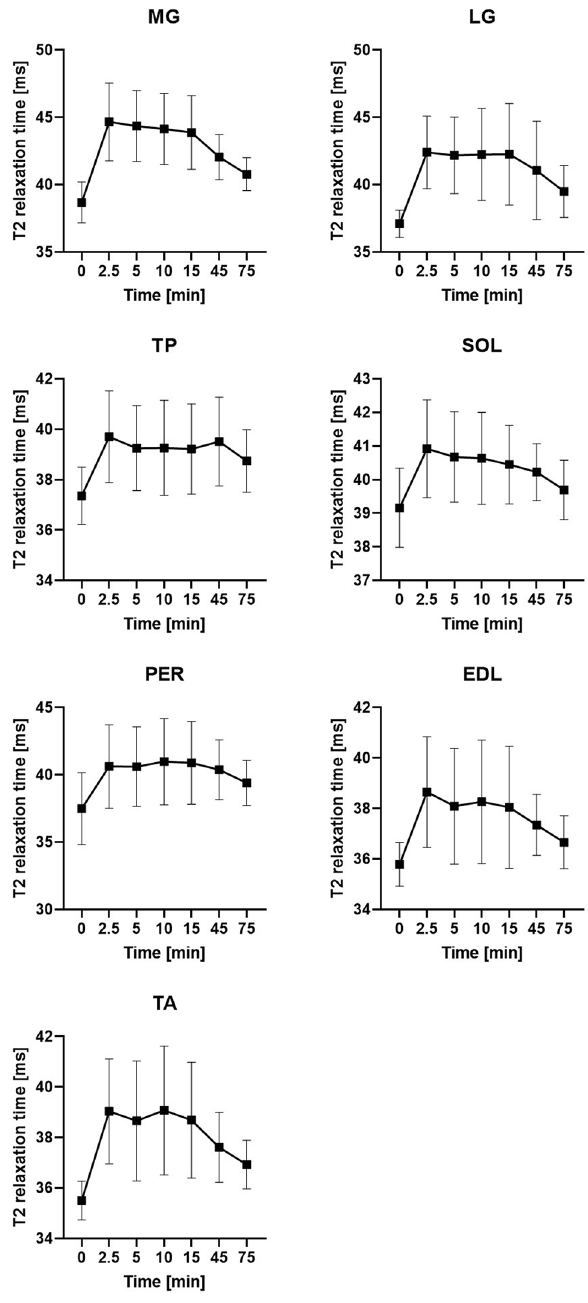
Figure 2. Mean relaxation times with standard deviation for the extrinsic foot